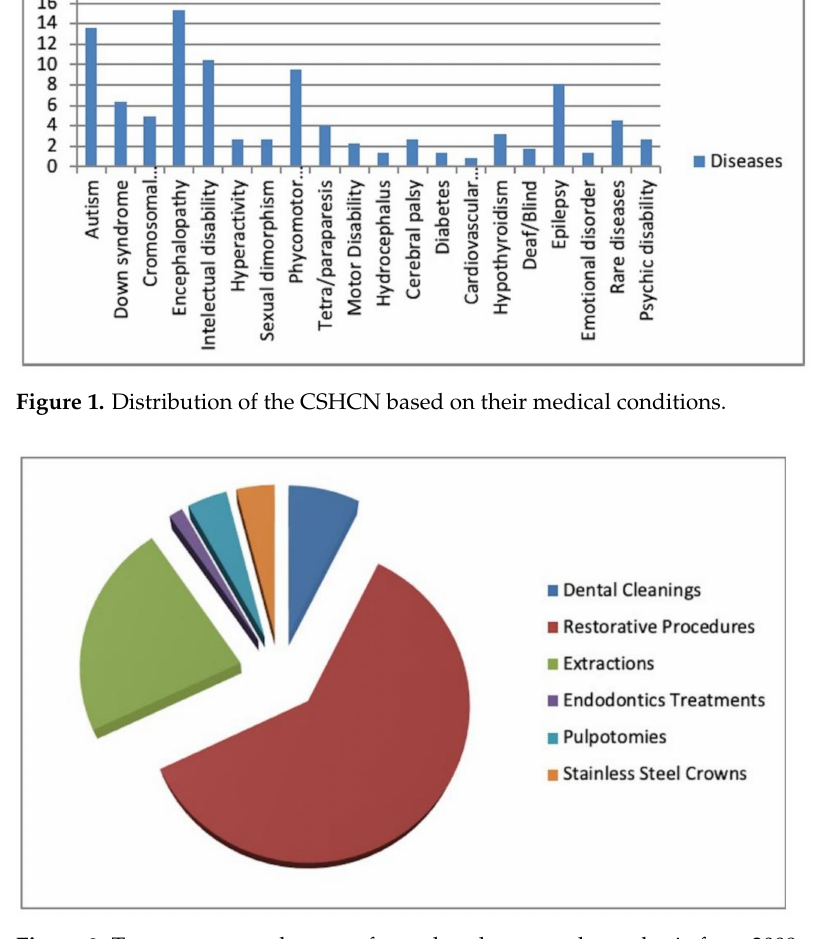
Figure 2. Treatment procedures performed under general anesthesia from 2008 to